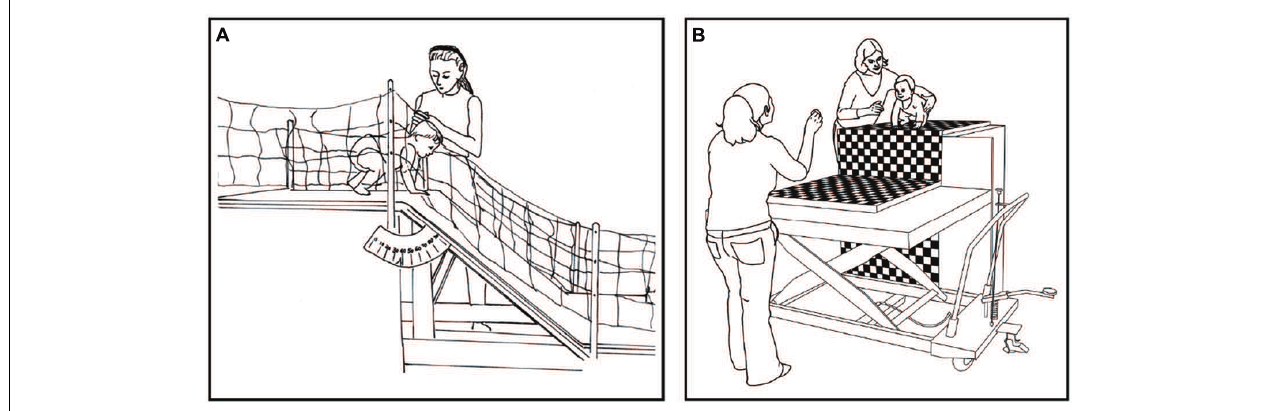
FIGURE 1 | (A) Adjustable slope apparatus used in previous work. (B) Adjustable drop-off apparatus. Infants began in a prone or upright position on the starting platform. An experimenter followed alongside infants to ensure their safety. The landing platform adjusted in 1-cm increments from 0 to 90 cm. In blocked test trials, mothers encouraged and discouraged infants’ descent; they stood at the landing